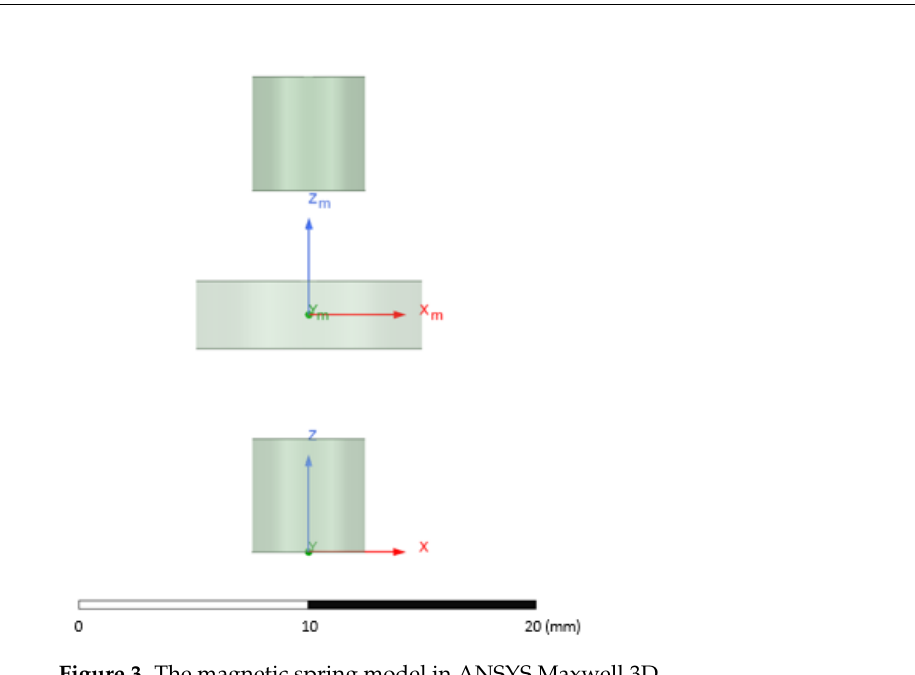
Figure 3. The magnetic spring model in ANSYS Maxwell 3D. Table 3. Coefficients of approximating polynomials of the magnetic force. range of −3 .2 mm to 3.2 mm and also rotationally around the x m -axis in the range of 0° to